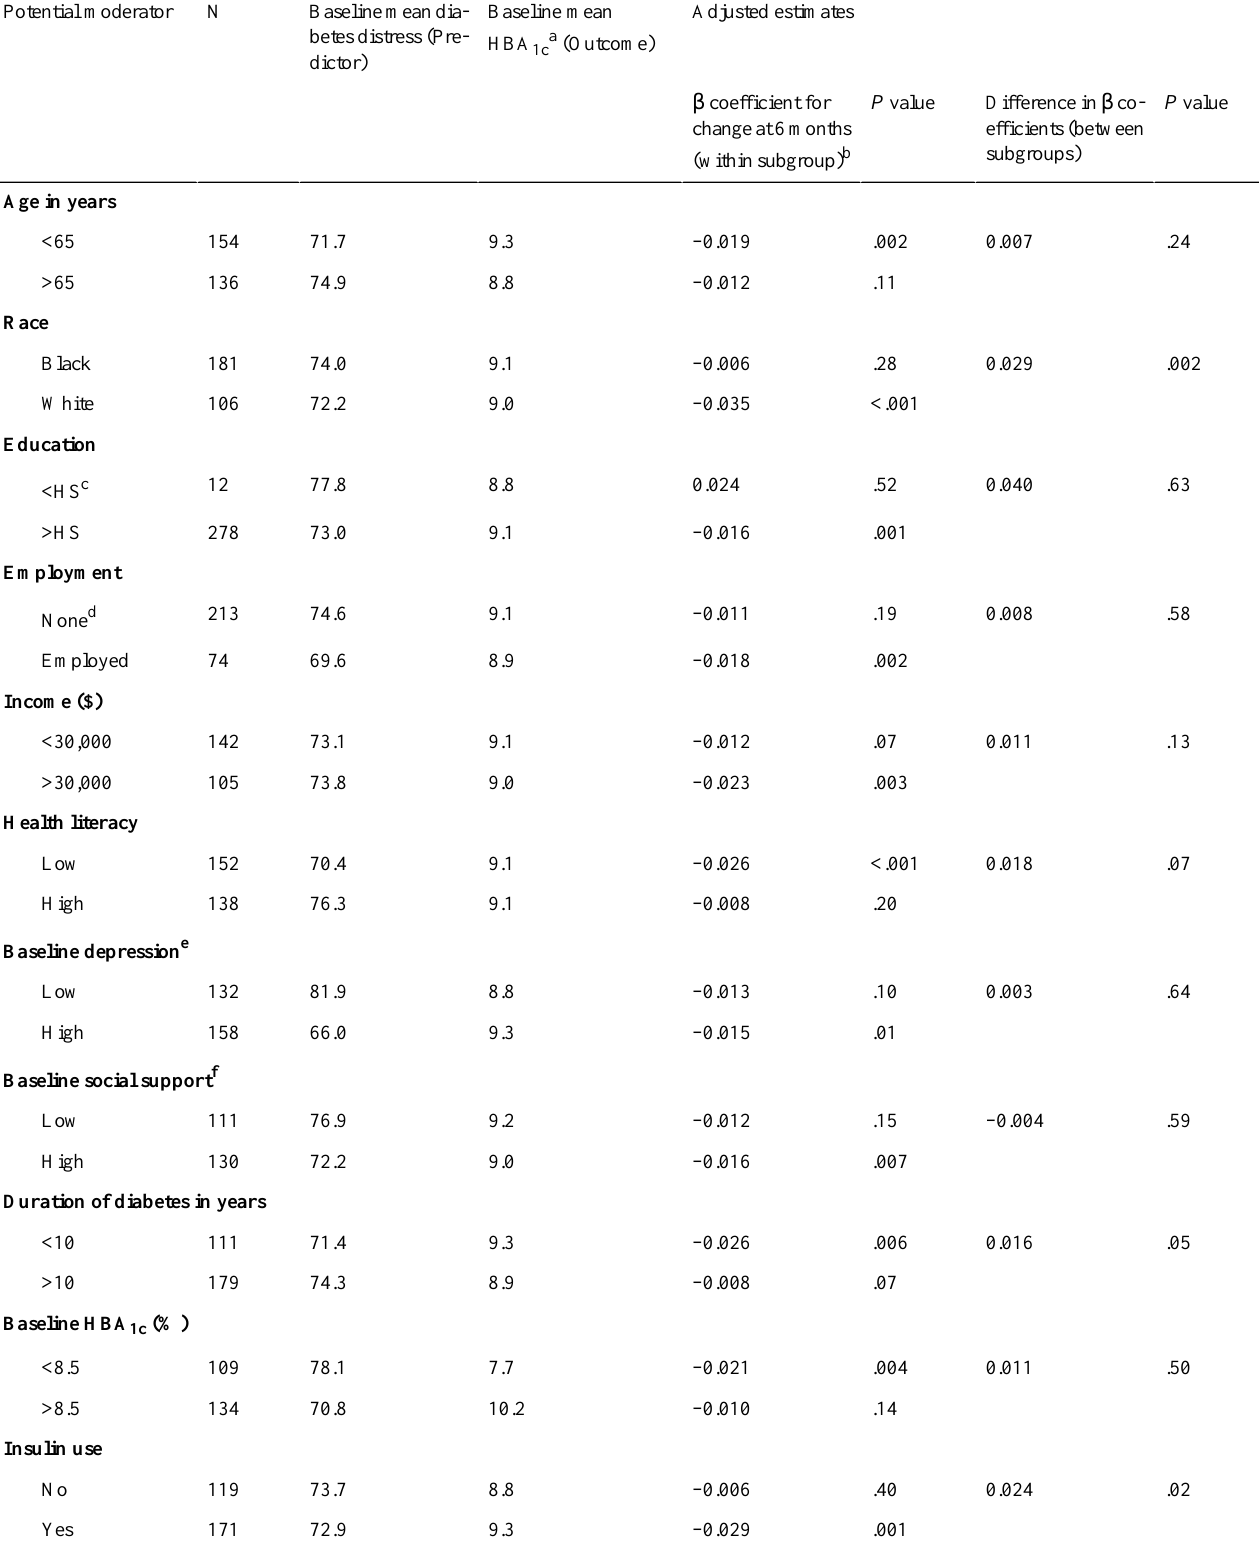
Table 4. Adjusted estimates on the effect of improved diabetes distress on improved glycemic control, by groups with different baseline characteristics (moderator